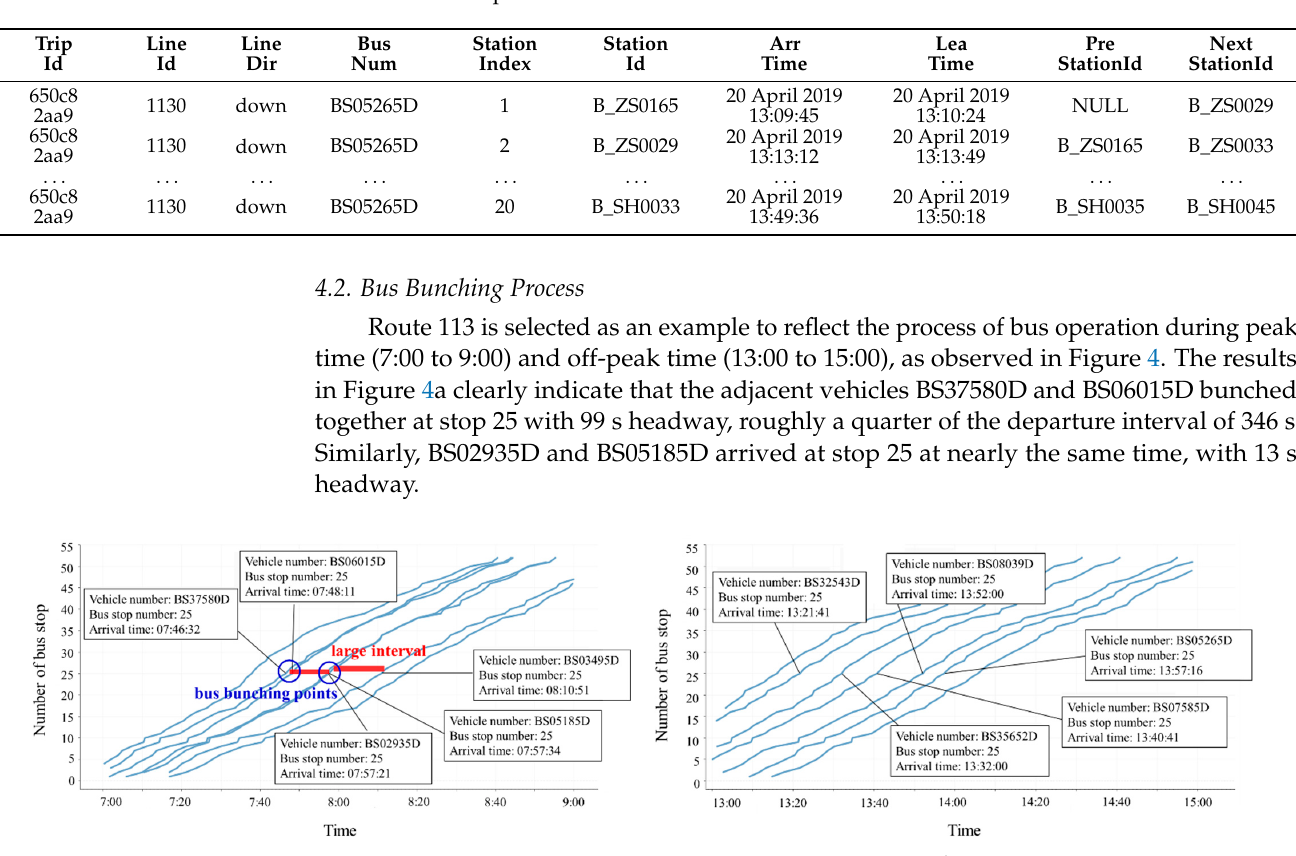
Table 2. Data samples of AVL.